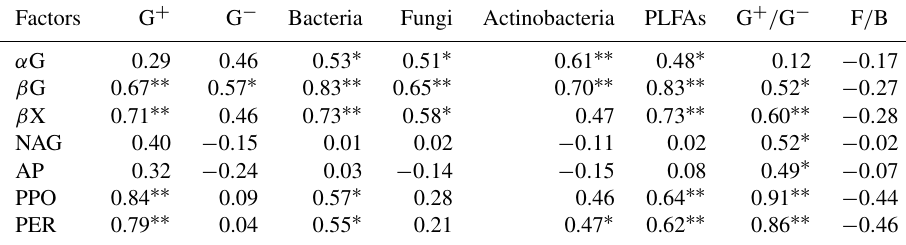
Table A4. Pearson correlation coefficients between PLFA contents and potential enzyme